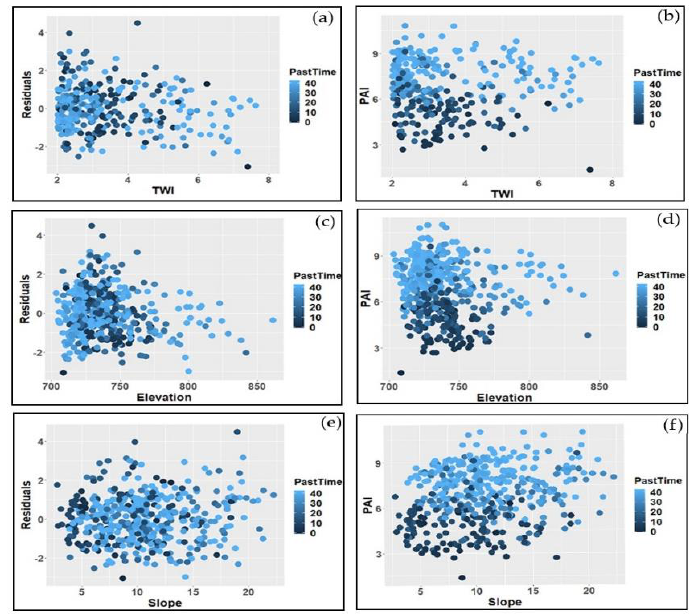
Figure 7. The left colmn showed the relationship between PAI residuals and ( a ) topographic wetness index (TWI), ( c ) elevation, and ( e ) slope. The right colmn showed the relationship between the PAI values and ( b ) TWI, ( d ) elevation, and ( f ) slope. The color grediants represent the the past time after disturbance. Table 2. Effects of topographic factors on PAI values and residual values using stepwise multiple regression analysis.